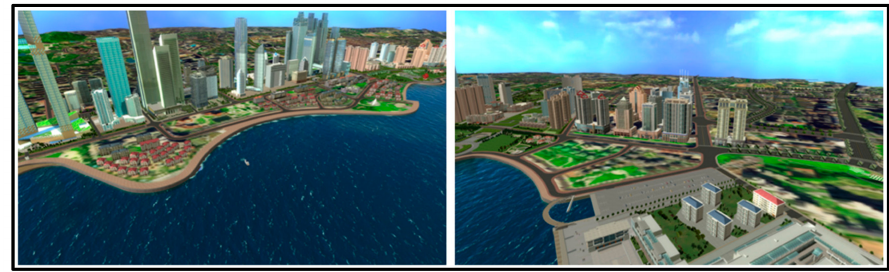
Figure 2. Our virtual traffic geographic environment